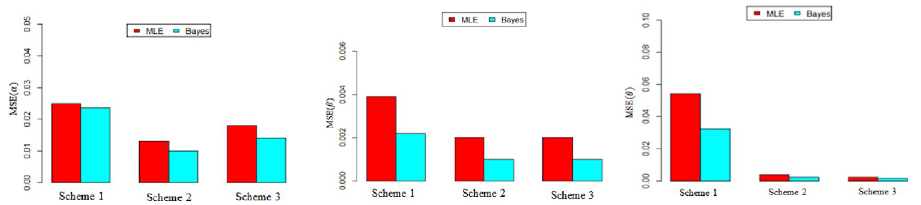
Fig 1. MSE of MOP parameters with various schemes with n = 50 and α = 2, θ = 1.5, β = 0.5.